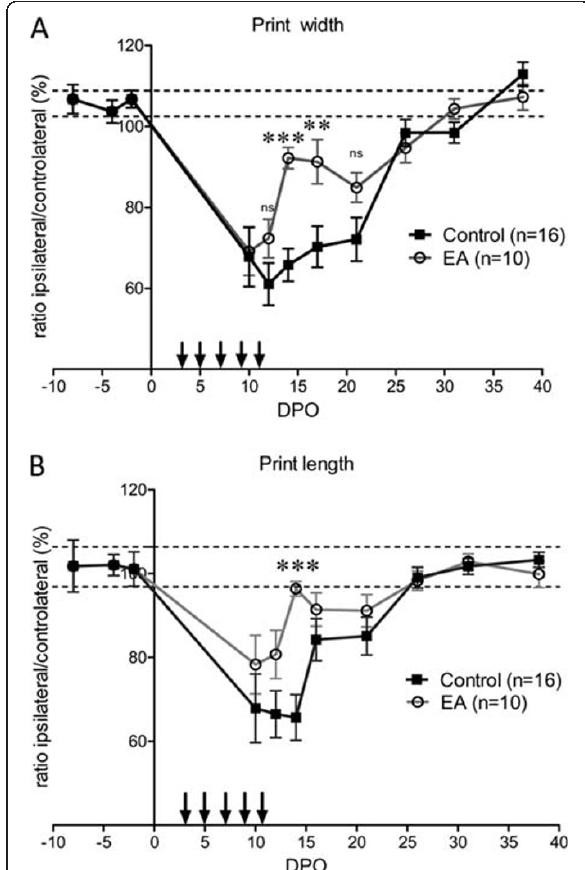
Figure 5 Analysis of individual parameters of paw print. ( A ) Print width is the width of the artificial box positioned around the paw print by the CatWalk software. Paw print could be recorded from 10 DPO. The width of the injured paw print was roughly 60 – 70% of normal value for several days, and rapidly recovered to normal values after 21 DPO. Print width of electro-acupuncture (EA) treated mice was significantly larger at 14 and 17 DPO. Total time for recovery was similar to control mice. ( B ) Print length is the length of the artificial box which the CatWalk software positions around the paw print. The print length of the injured paw was 65% of the normal value from 10 – 14 DPO and then rapidly recovered to a normal value at 26 DPO. The print length of electro-acupuncture treated mice showed the same length of time for a full recovery as control mice, but displayed a significant apparent and transient recovery at 14 DPO. ** p<0.01, *** p<0.001